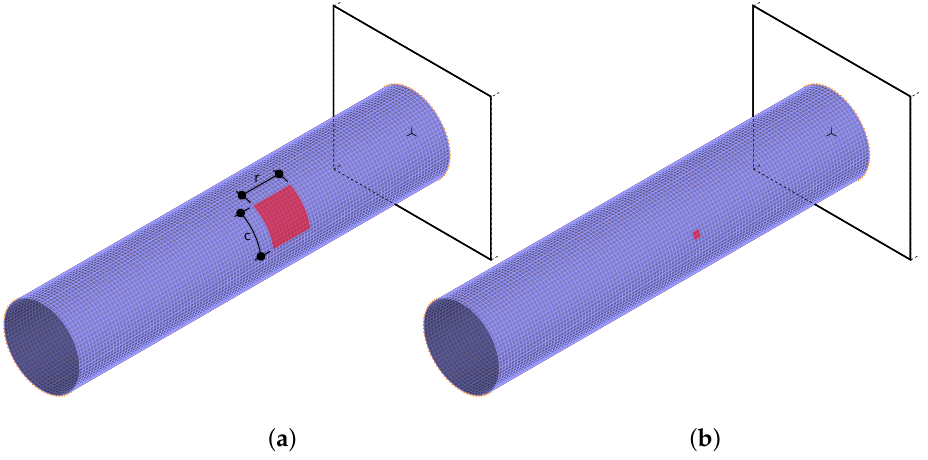
Figure 8. The highest ( a ) and smallest ( b ) areas with a degradation of material model parameters in half of the composite